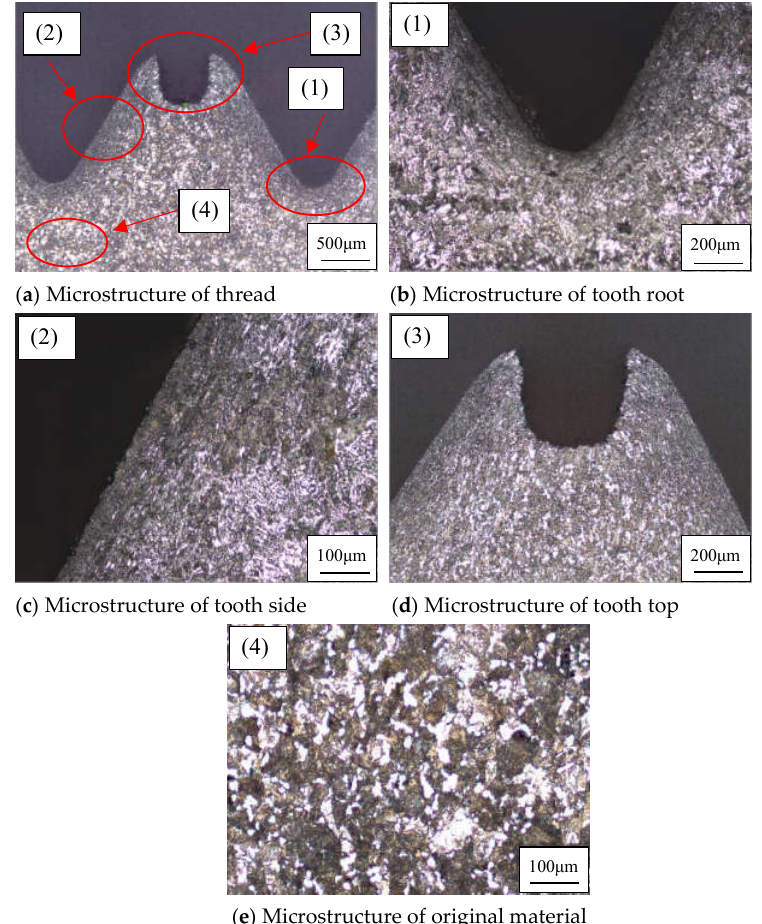
Figure 10. Microstructure of extruded thread. It can be seen from Figure 10a that the microstructure of the thread after extrusion has changed significantly. Compared with the part without extrusion, the degree of grain refinement and the density of fiber structure are significantly improved. When the thread is extruded by the tap, the metal of the workpiece flows in the groove between the two teeth of the tap. The grains are twisted and stretched along the direction of metal flow. With the increase in the amount for extrusion, the surface structure is compressed to fi- brous. The method of extrusion does not block the flow of fiber tissue, and fiber tissue from the tooth root to tooth top is still